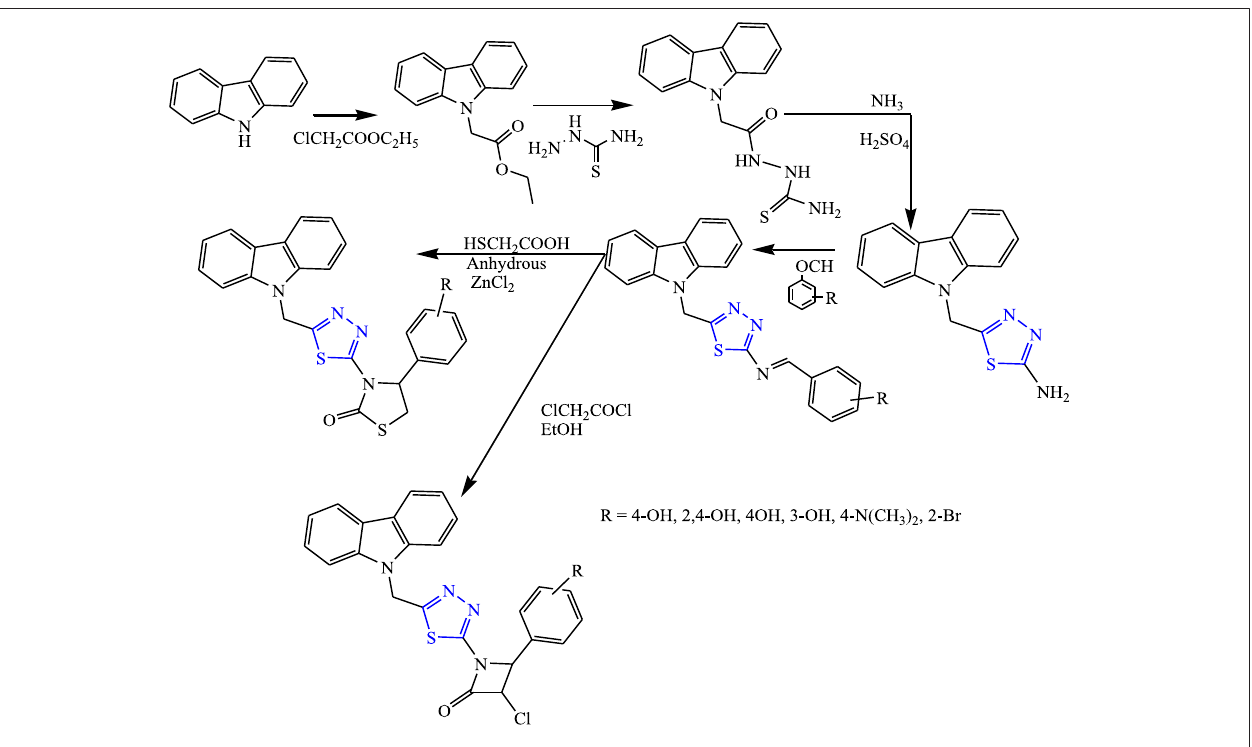
FIGURE 24 | Systematic scheme for synthesizing thiadiazolylazetidinonyl carbazole derivatives.